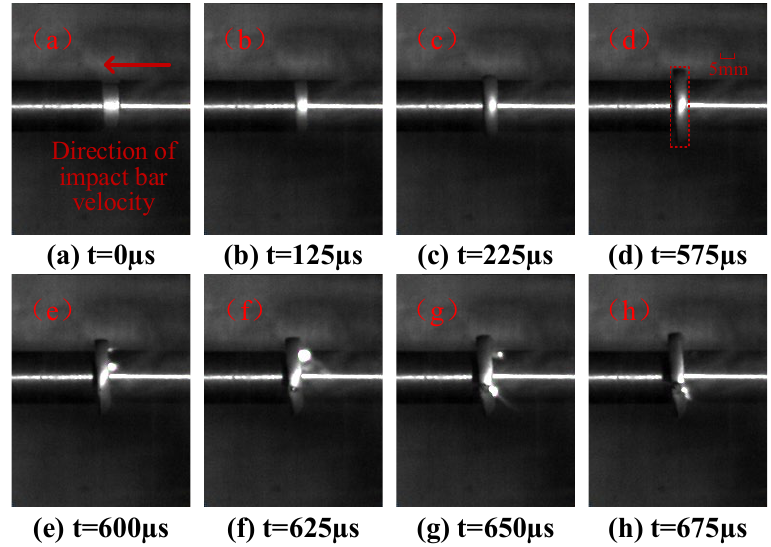
Figure 11. The impact ignition process of reinforced Al/PTFE.